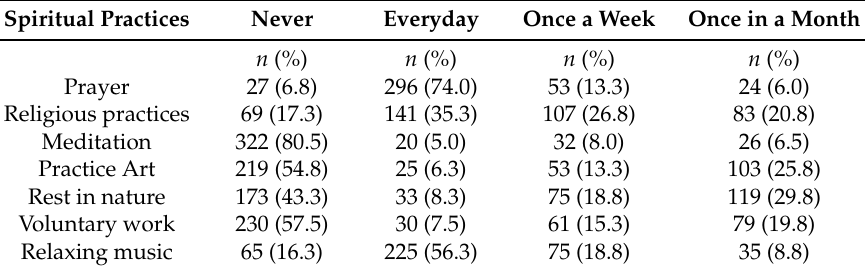
Table 3. Spiritual care practices of nursing students ( n = 400).